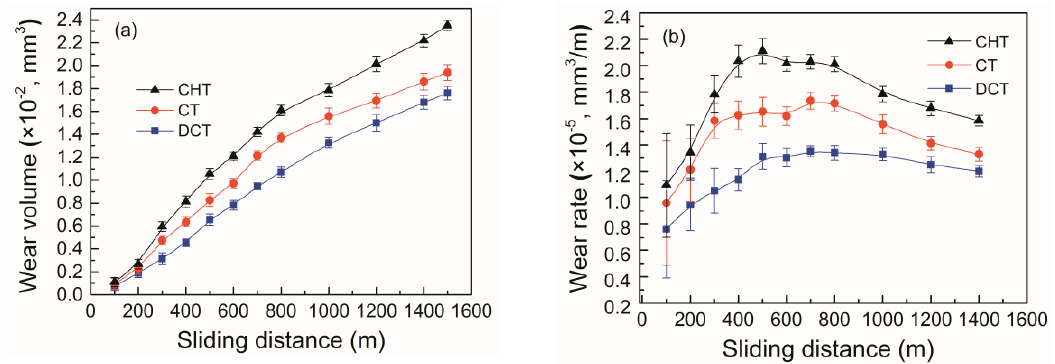
Figure 4. Wear volume ( a ) and wear rate ( b ) vary with sliding distance of samples under different heat treatment.